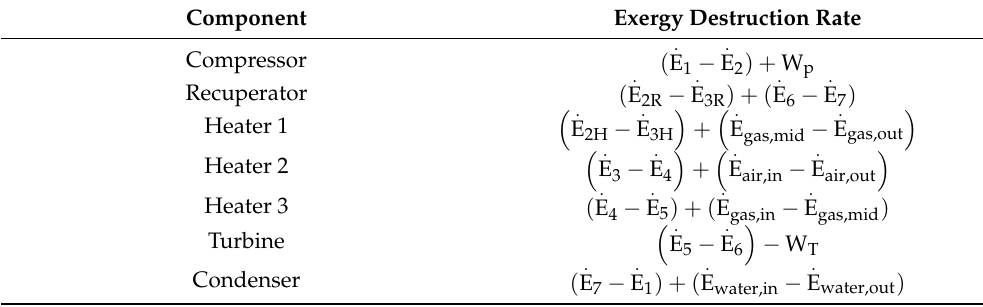
Table 6. Exergy destruction rate for each component of the optimal split cycle